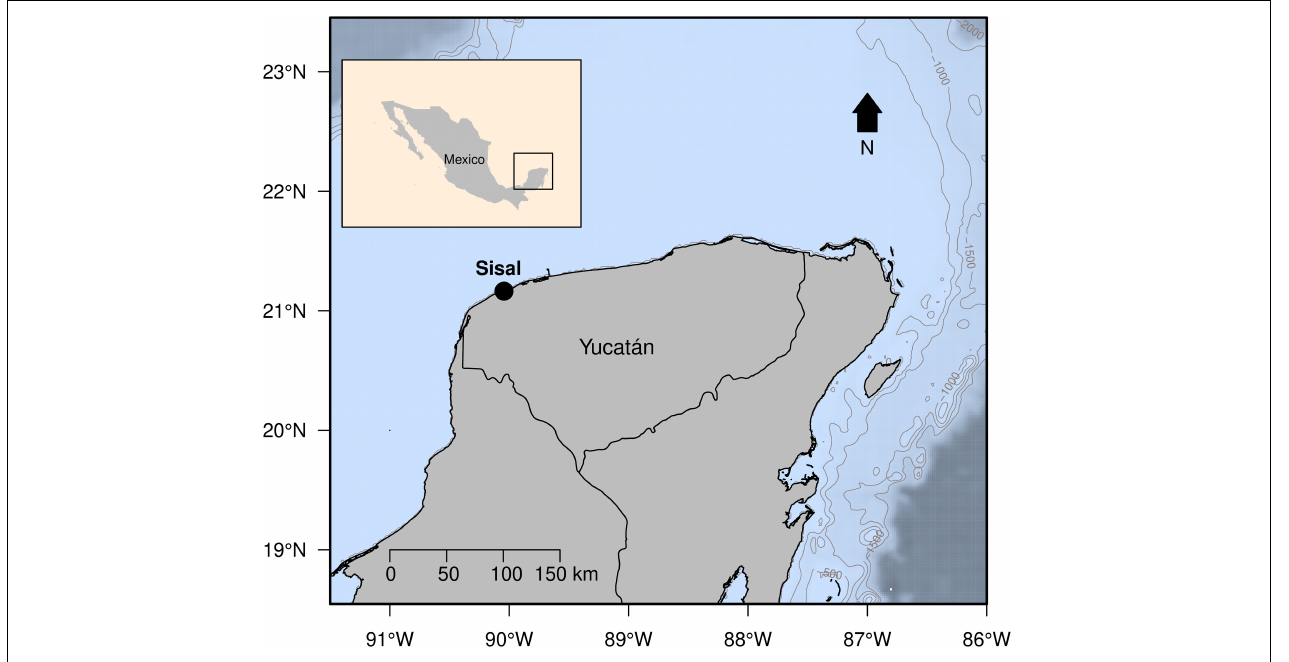
FIGURE 1 | Geographic location of Sisal port, Yucatán,